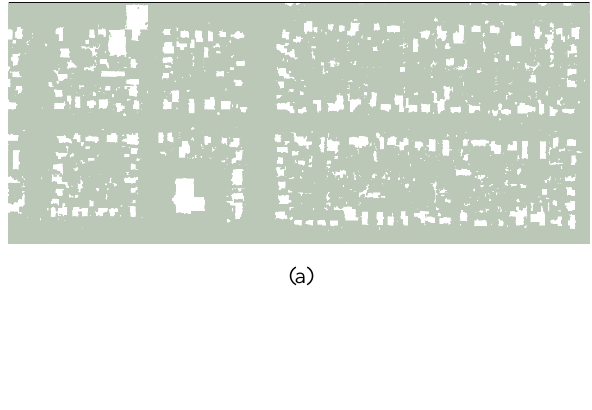
Figure 8. Primitives extraction, (a) is the extracted planar or smooth surfaces, and (b) is the extracted rough surfaces.